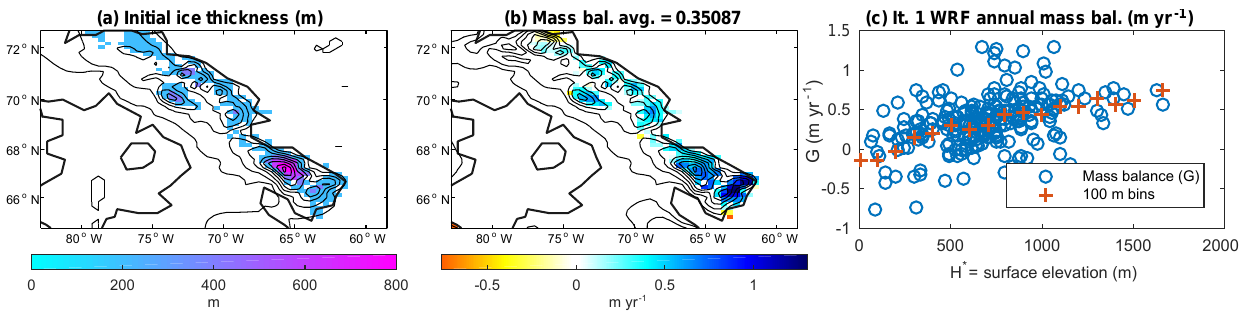
Figure 1. Ice thickness and mass balance for ice sheet initialization: (a) ice thickness was adapted from data collected by the NASA Operation IceBridge mission (Kurtz and Farrell, 2011) with extent set by land use type in WRF. (b) Annual mass balance from the WRF Iteration 1 run. (c) Scatter plot of mass balances vs. elevation with a binned regression